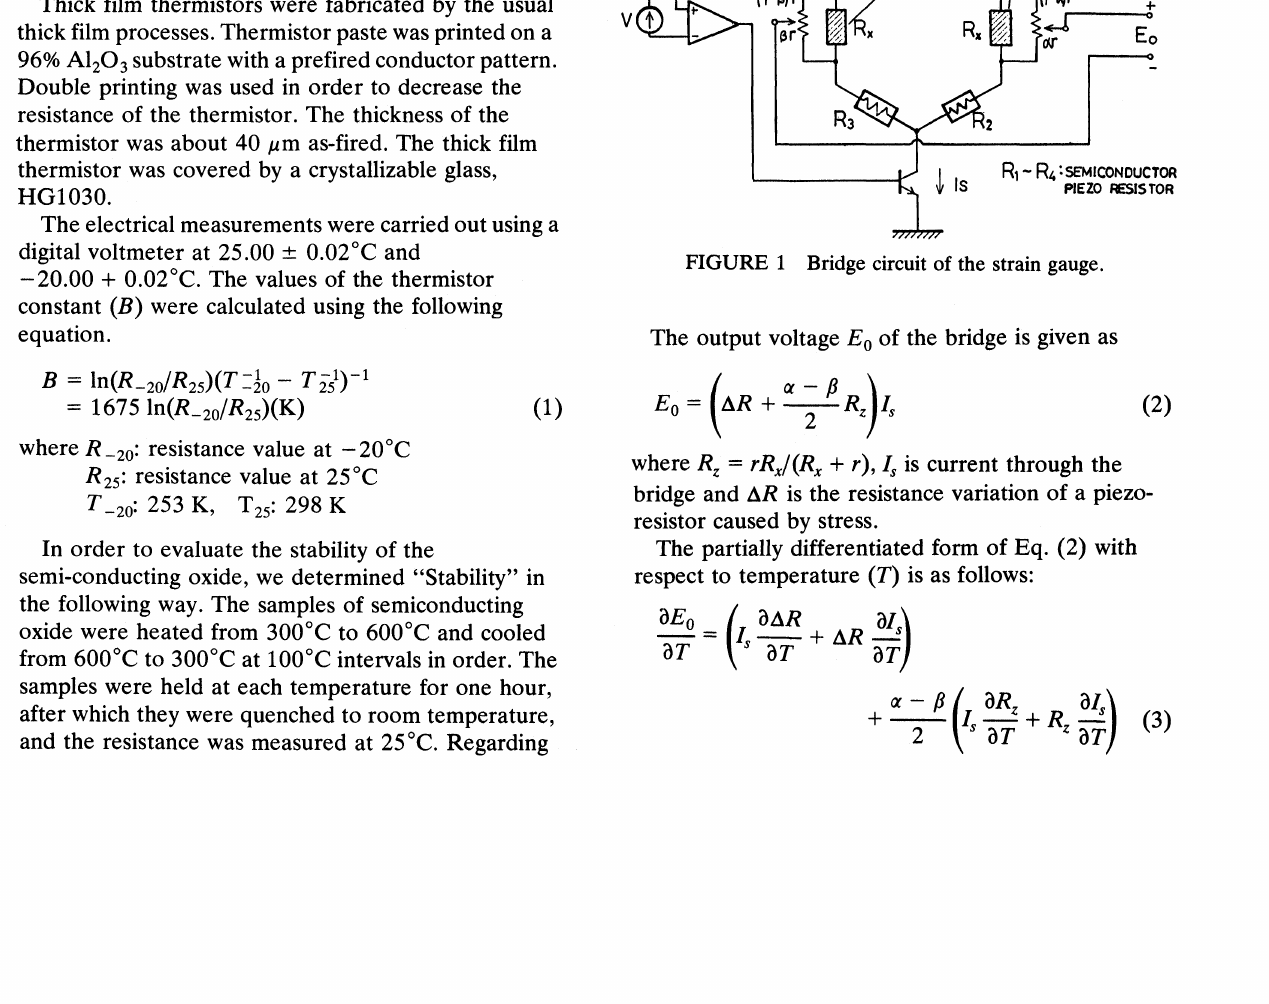
FIGURE Bridge circuit of the strain